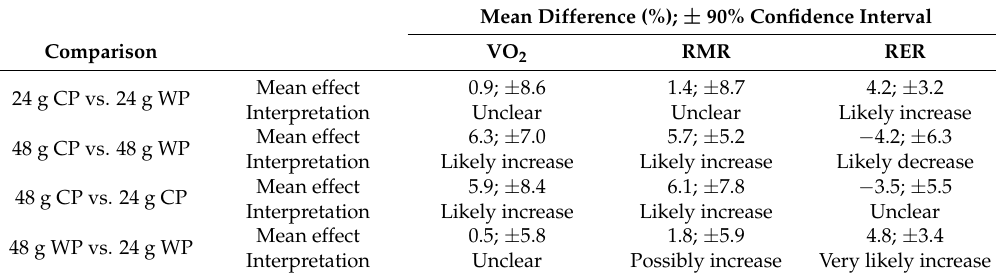
Table 2. Comparison of Metabolic Variables between Protein Type and